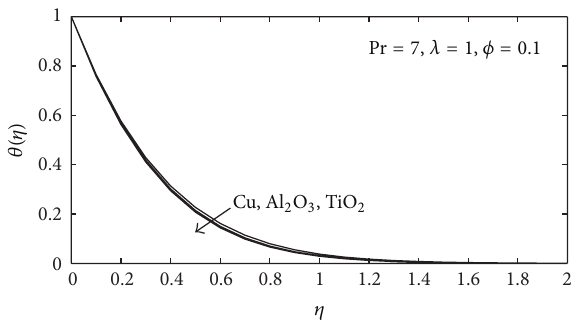
Figure 7: Temperature profiles 𝜃(𝜂) for different types of nanopar- ticles when Pr = 7 , 𝜙 = 0.1 , and 𝜆 = 1 .